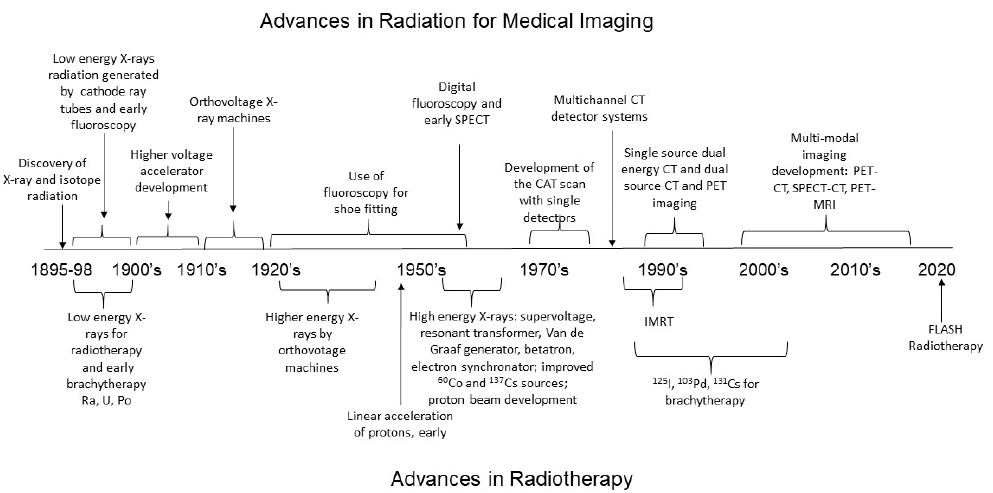
Figure 1. Timeline of advances in radiation for medical imaging and radiotherapy. The discovery of radiation led rapidly to its use for imaging in medicine and its use in cancer therapy. CT—computerized tomography; MRI—magnetic resonance imaging; PET-photon emission tomography; SPECT—single-photon emission computerized tomography.